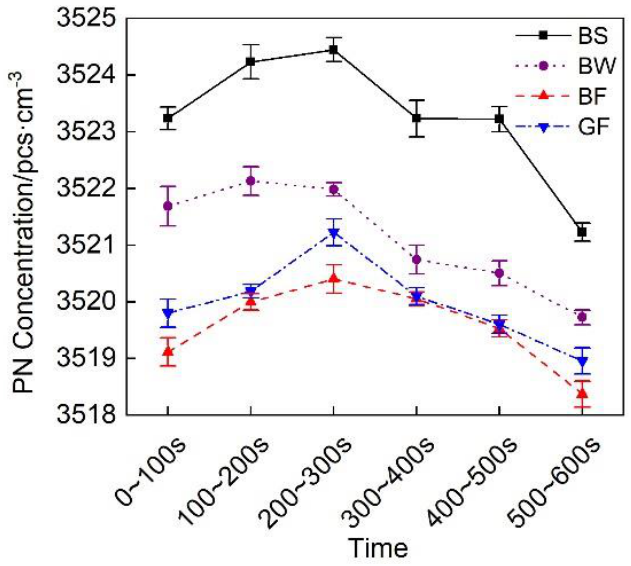
Figure 16. PN concentration of the different exhaust pipe covering schemes at each substage of the initial idling stage.